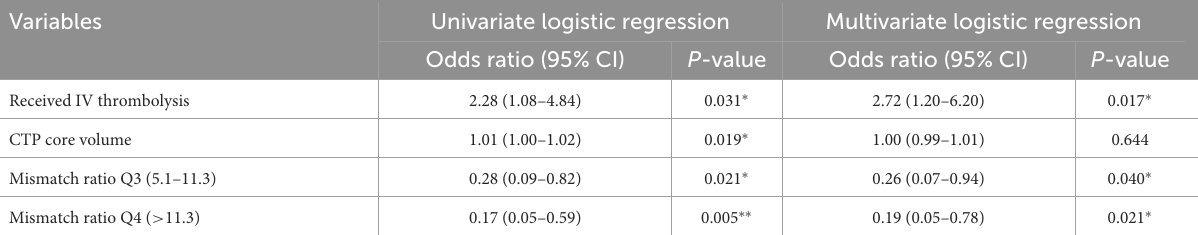
TABLE 3 Univariate and multivariate logistic regression analyses between demographic, clinical, laboratory indicators, perfusion profile at baseline CT perfusion, and RPBE.